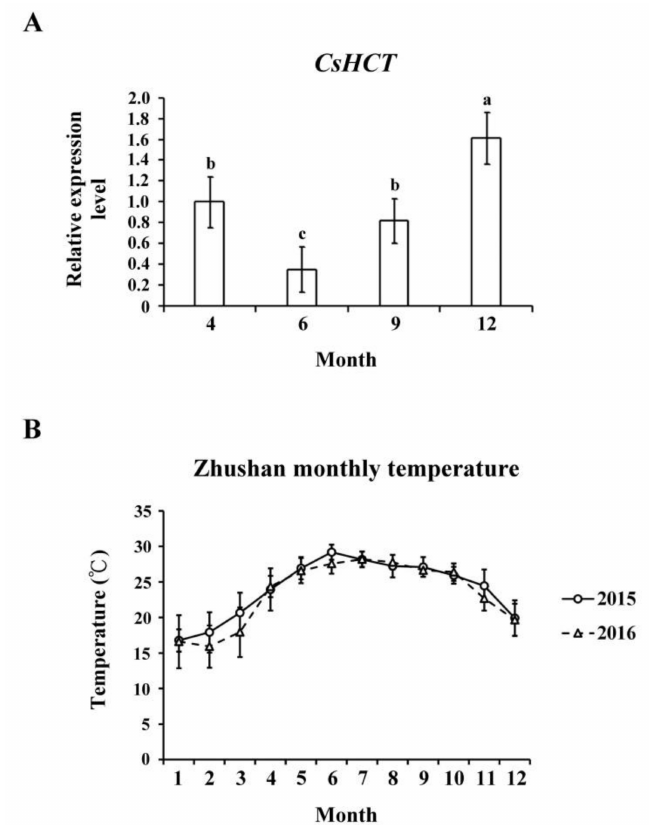
Figure 4. CsHCT transcription levels in four growing seasons. ( A ) The qRT-PCR analysis of CsHCT transcription levels in four growing seasons in the field. ( B ) Monthly average temperature in the Zhushan area. Total RNA was isolated from tissues of handpicked one-tip-two-leaf oolong tea samples collected in April, June, September, and December. Transcript levels of CsHCT were calculated and normalized to that of 18S rRNA . Values represent means ± SD from five biologically independent experiments. Values with different letters are significantly different at p < 0.05, according to a post hoc least significant difference (LSD)